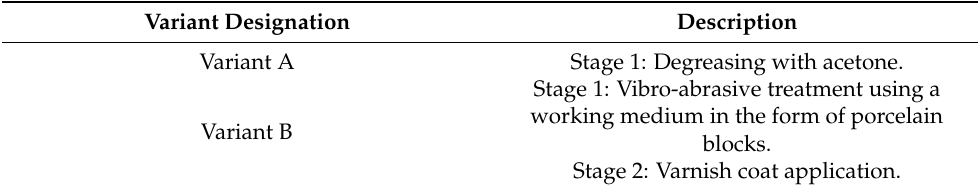
Table 4. Variants of adherends surface treatment.